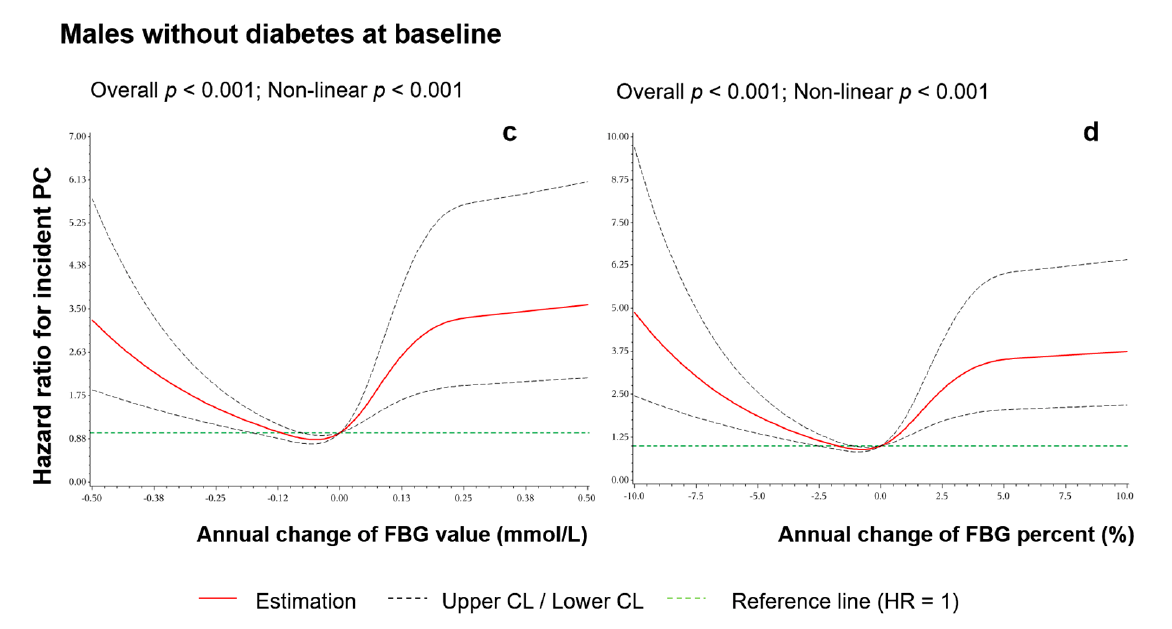
Figure 1. Non-linear associations between annual FBG change and the risk of PC. ( a ) Annual change in FBG value in all males, ( b ) annual change in FBG percent in all males, ( c ) annual change in FBG value in males without diabetes at baseline, and ( d ) annual change in FBG percent in males without diabetes at baseline.